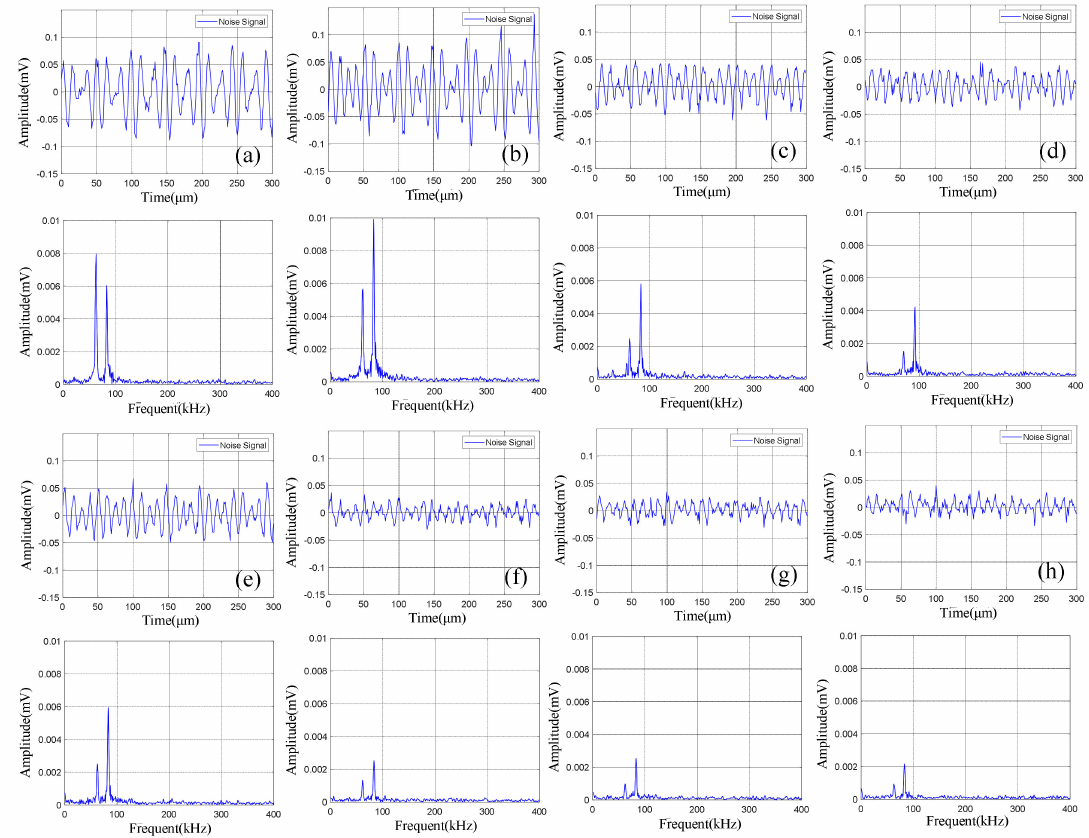
Figure 10. Time domain-frequency domain diagram of 0–600 cycles of discharge of Group B batteries: ( a ) 0 cycles; ( b ) 10 cycles; ( c ) 100 cycles; ( d ) 200 cycles; ( e ) 300 cycles; ( f ) 400 cycles; ( g ) 500 cycles; ( h ) 600